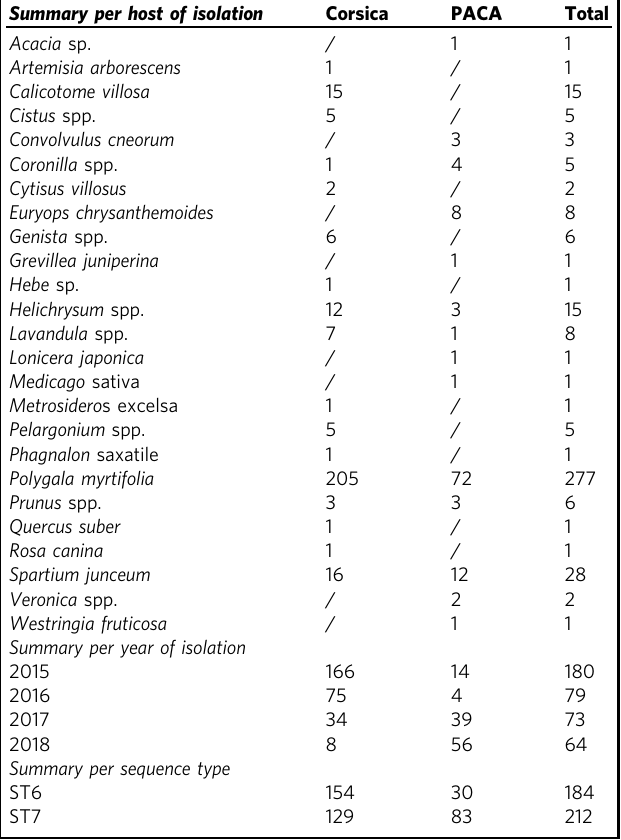
Table 3 Genetic diversity based on 13 VNTRs in the 396 French samples.